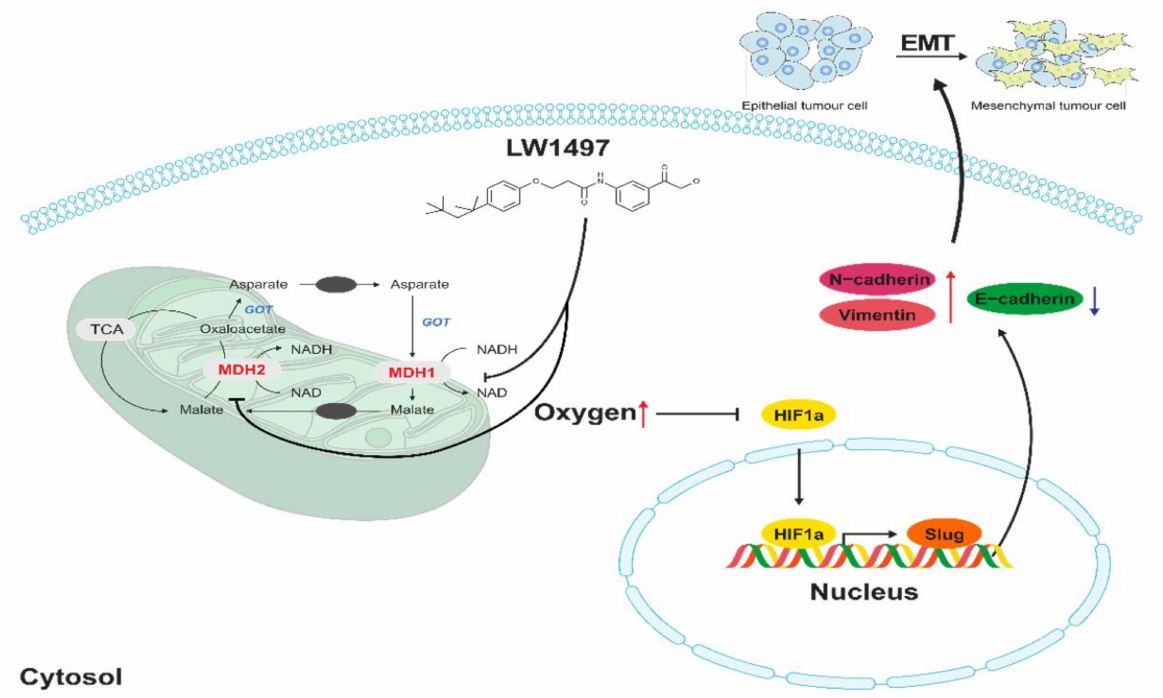
Figure 6. Effects of LW1497 on Slug expression. Treatment of LW1497 induces the inhibition of MDH1 and MDH2, which reduces oxygen consumption, thus increasing the concentration of oxygen locally. Thus, by inducing a decrease in the expression of HIF-1 α , HIF-1 binding to HRE in the promoter site of Slug is reduced, thereby reducing the transcription of Slug. The increase in the concentration of local oxygen due to LW1497 has been reported in Naik et al. [13], while the involvement of Slug in regulating the expression of cadherins and Vimentin has been reported by Hu et al.